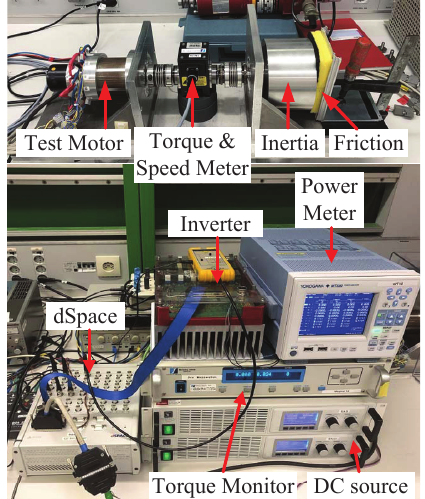
Figure 12. Test bench studied in this paper.